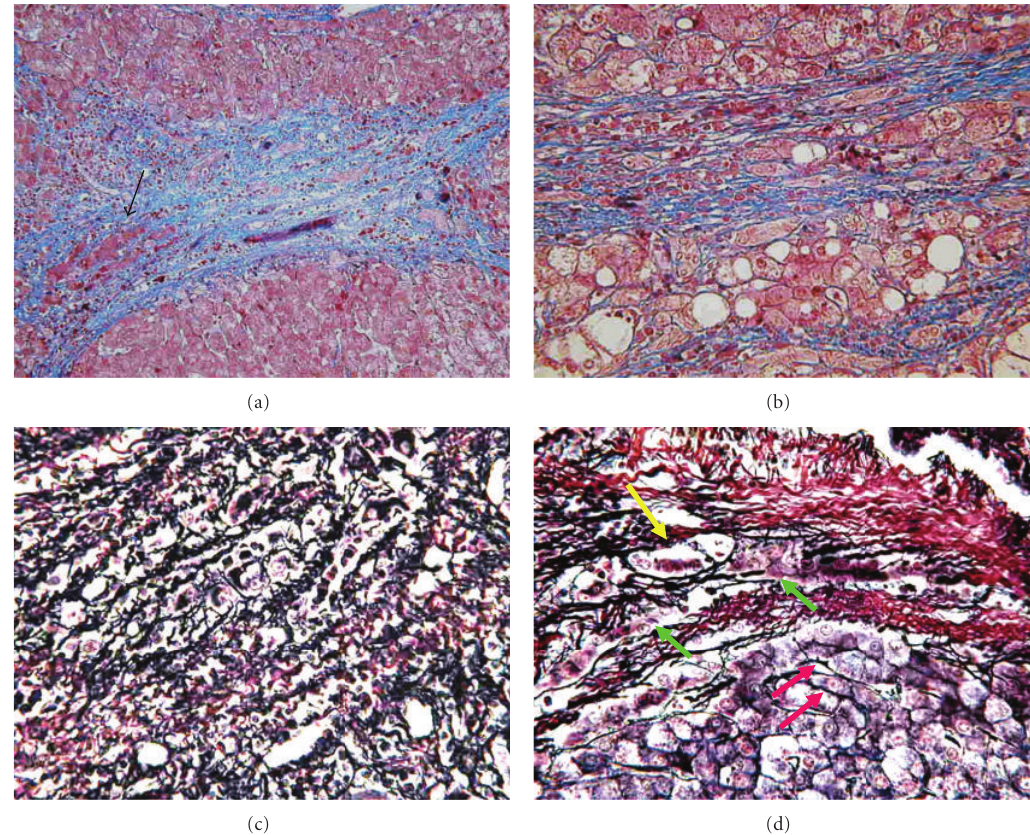
Figure 2: Histological features which make the assessment of stromal invasion di ffi cult (a) True stromal invasion of very mild grade. The fibrous septum is almost intact except for a small area (arrow). (b) Pseudo-invasion consisting of very thin fibrous bundles within and around thick liver cell cords. This pattern was formed by dissection of liver parenchyma by very thin fibrous tissue. (c) A specimen of very poorly performed silver stain. (d) Silver stain of HCC tissue within and around a fibrous septum. Reticulin fibers circumscribing cancer tissue are seen even in the area of true invasion (yellow arrow). However, noncircumscribed tumor cells are also seen in the same fibrous septum (green arrows). This area is a “battle front” of invasion. Red arrows show ordinary tumor tissue with reticulin fibers surrounding the fibrous